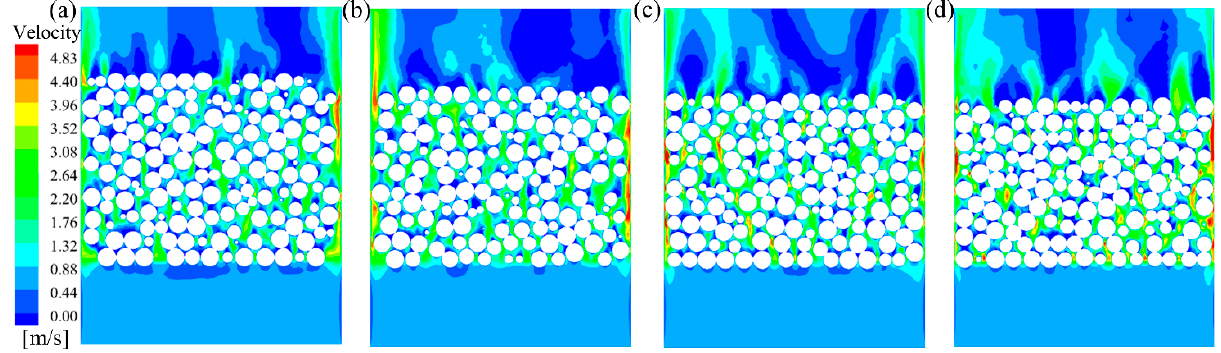
Figure 7. The contours of velocity under different vertical pressures at inlet velocity V 0 = 0.6 m/s: